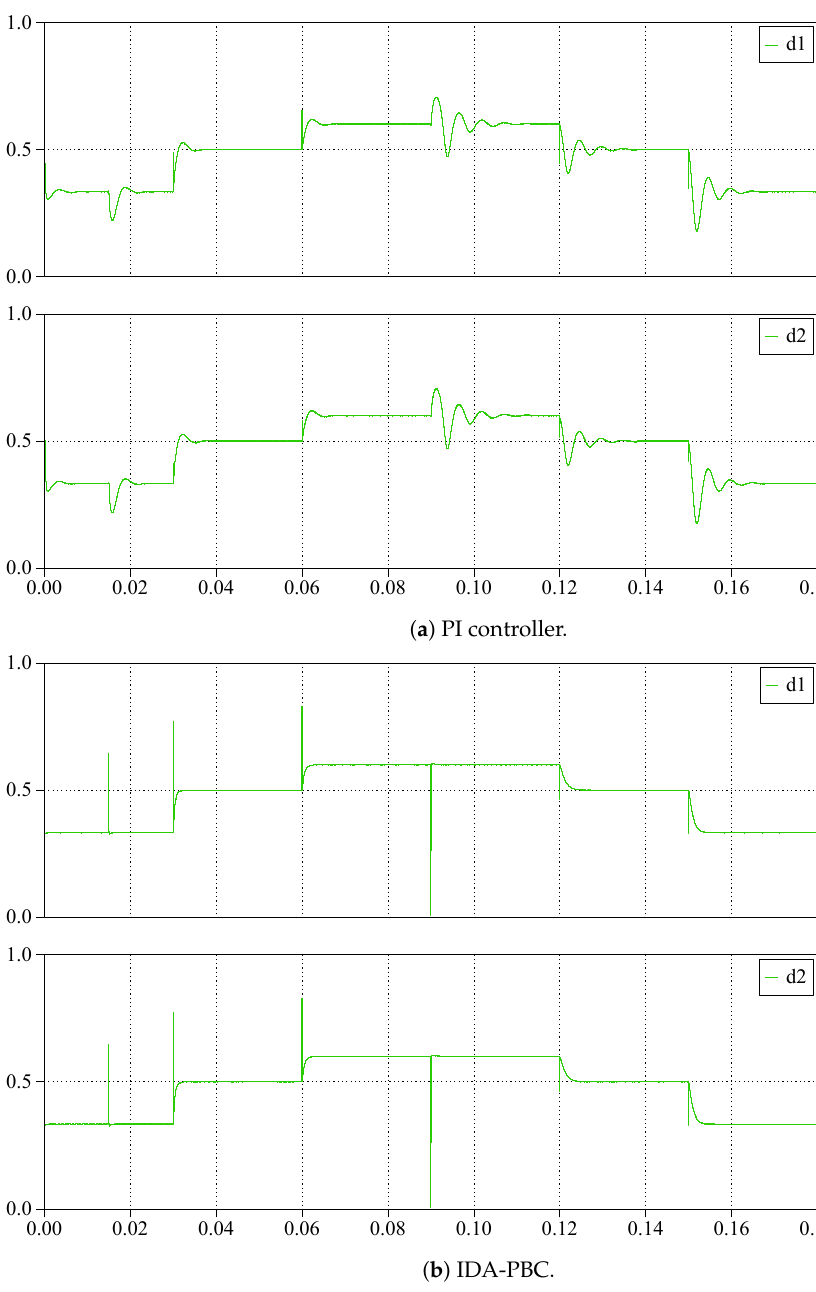
Figure 10. The dynamic response of control inputs with the interleaved boost converter under different DC voltage and current